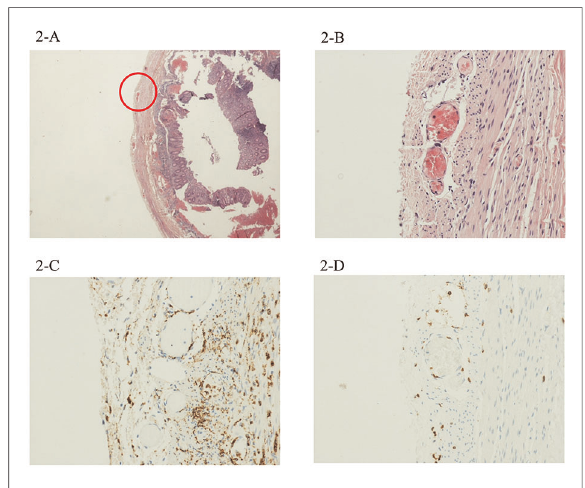
FIGURE 2 The second case showed mild in fl ammation, but with a perivascular involvement mostly by CD68 + macrophages ( C ), with very few CD3 + lymphocytes ( D ). Magni fi cation 4× ( B ) and 20× ( A